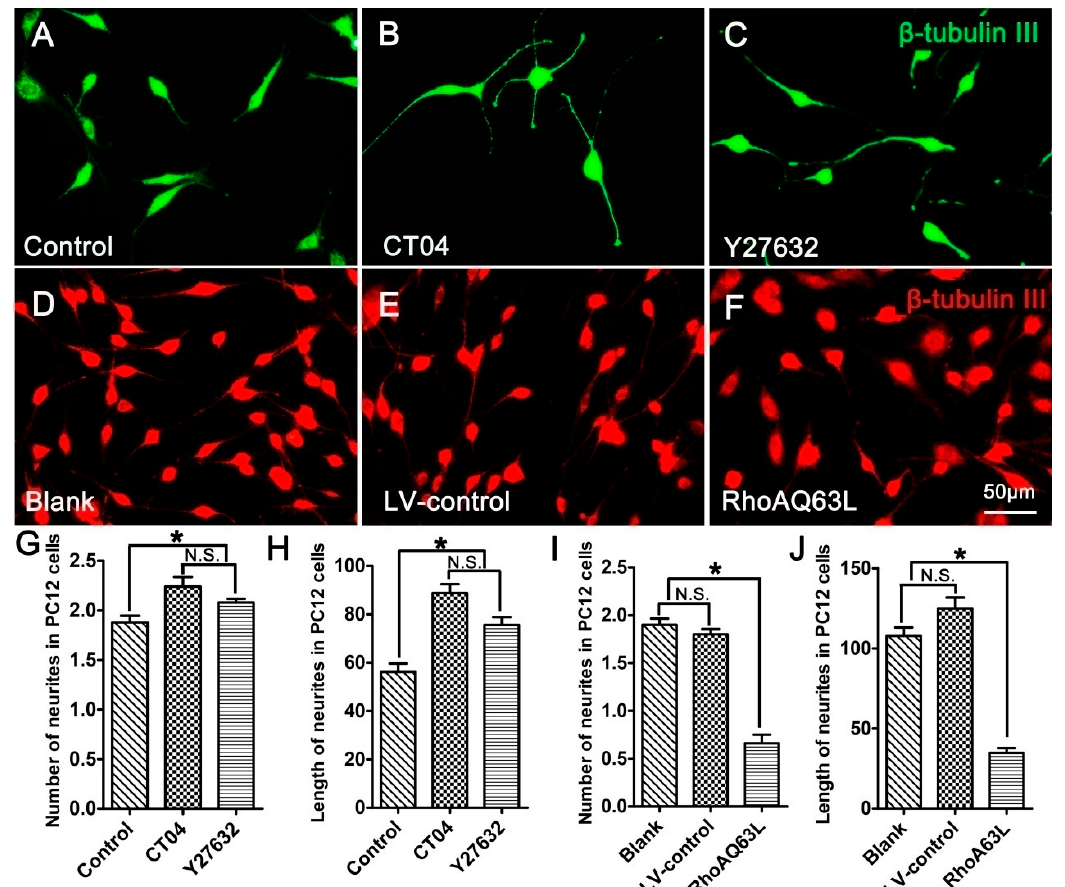
Figure 2. The RhoA signaling pathway negatively regulates neurite outgrowth in neuronally differentiated PC12 cells. ( A – C ) Representative immunofluorescence images of β -tubulin III-positive differentiated PC12 cells in different drug treatment groups. Quantitative analyses of the average number ( G ) and length ( H ) of the neurites of each cell in different groups. Compared with the control group, CT04 or Y27632 treatment increased the number and length of the neurites. ( D – F , I , J) Representative immunofluorescence staining for β -tubulin III (red) revealed that overexpression of the constitutively activated RhoA reduced neurite outgrowth in PC12 cells. The data are shown as the mean ± SEM values (*indicates p < 0.05, meaning a statistically significant difference, while N.S. indicates nonsignificance).